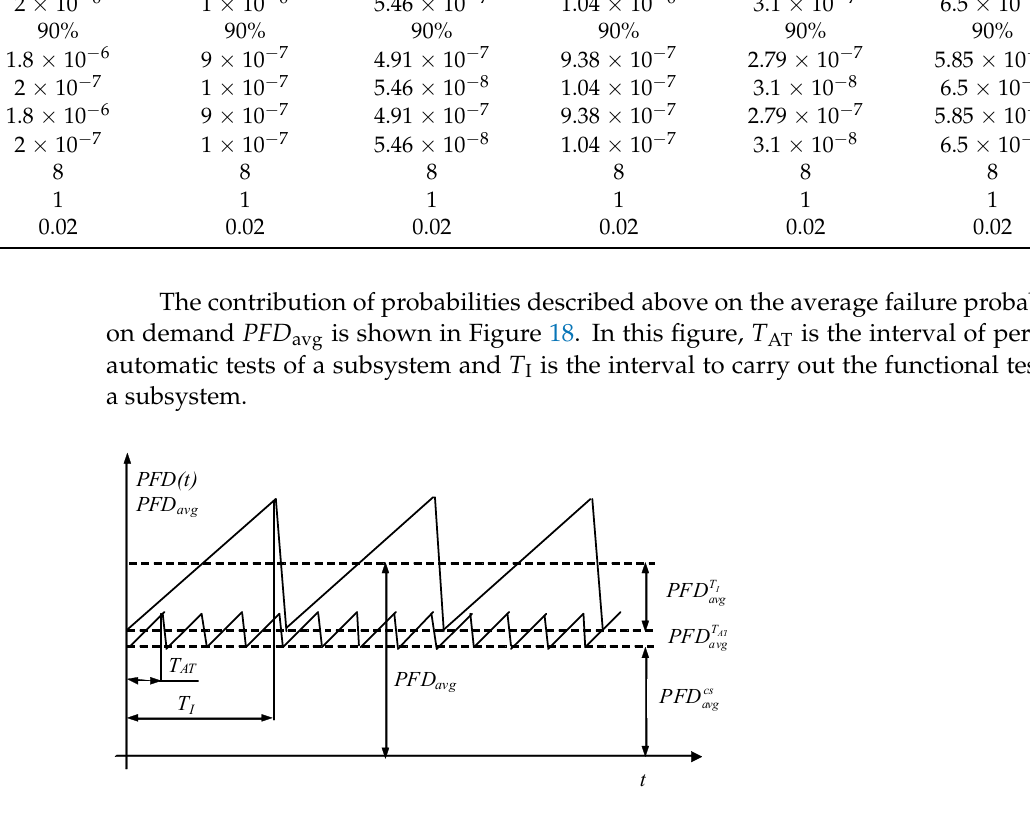
Table 10. Reliability data.